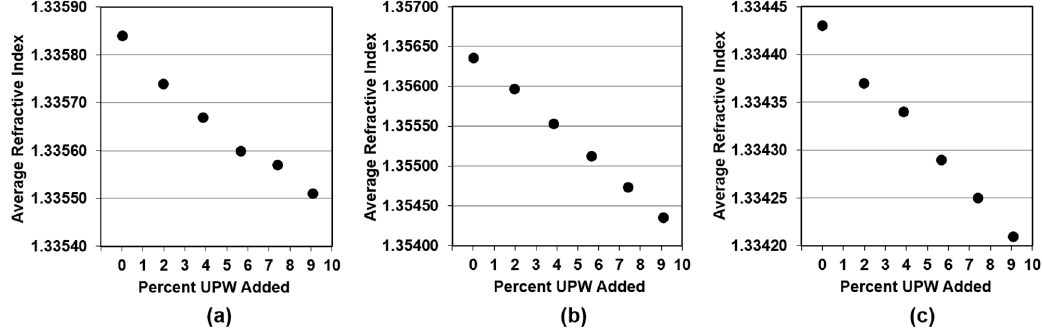
Figure 4. Average RI as a function of amount of UPW added for ( a ) Fujimi PL-7106; ( b ) Klebosol 1501-50; and ( c ) CMC W7801.